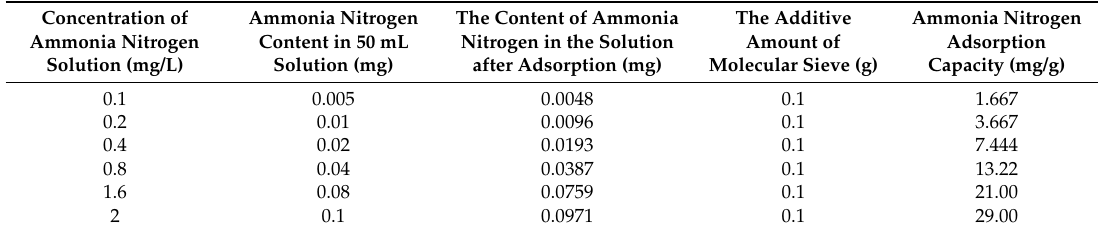
Table 2. Removal of ammonia nitrogen from SBA-15 molecular sieve.